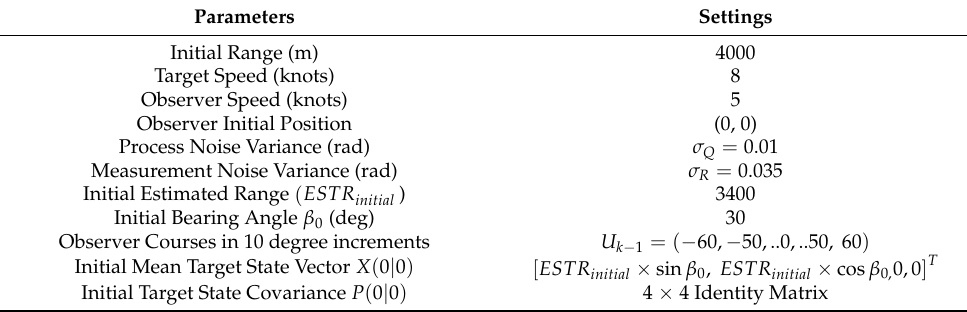
Table 1. Simulation Parameters for Single Observer Bearing Only Tracking